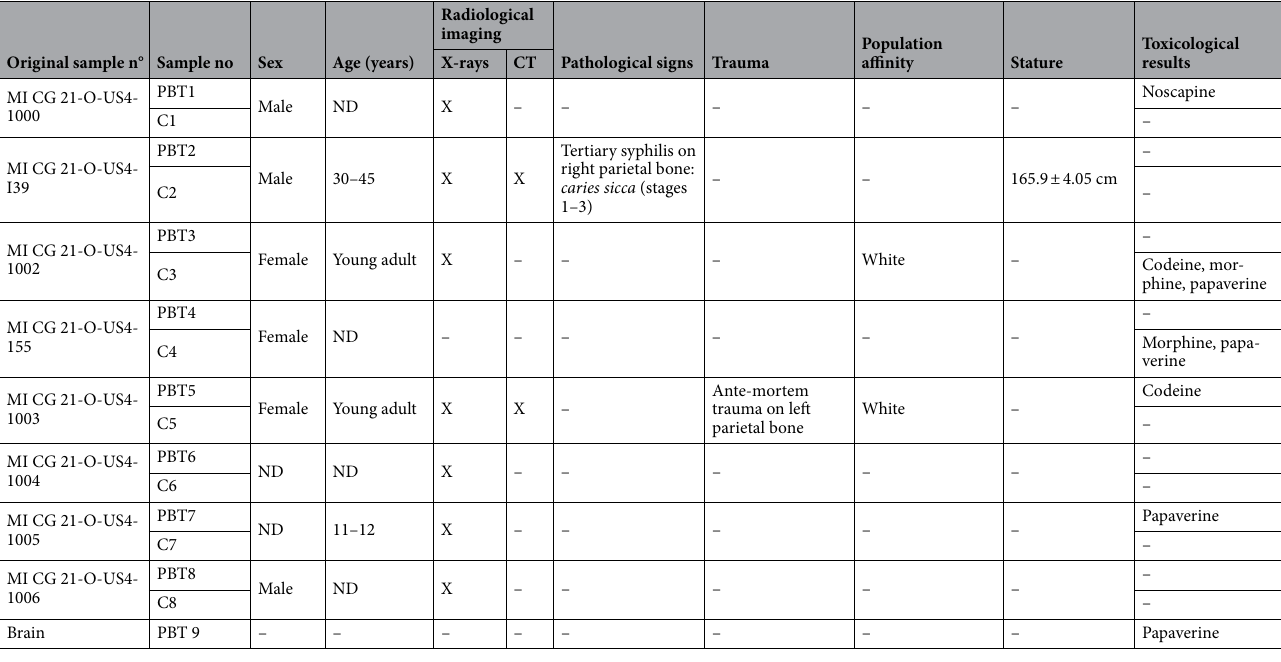
Table 2. Results of anthropological analyses performed on samples under investigation (X = performed, “ – ” = absent).